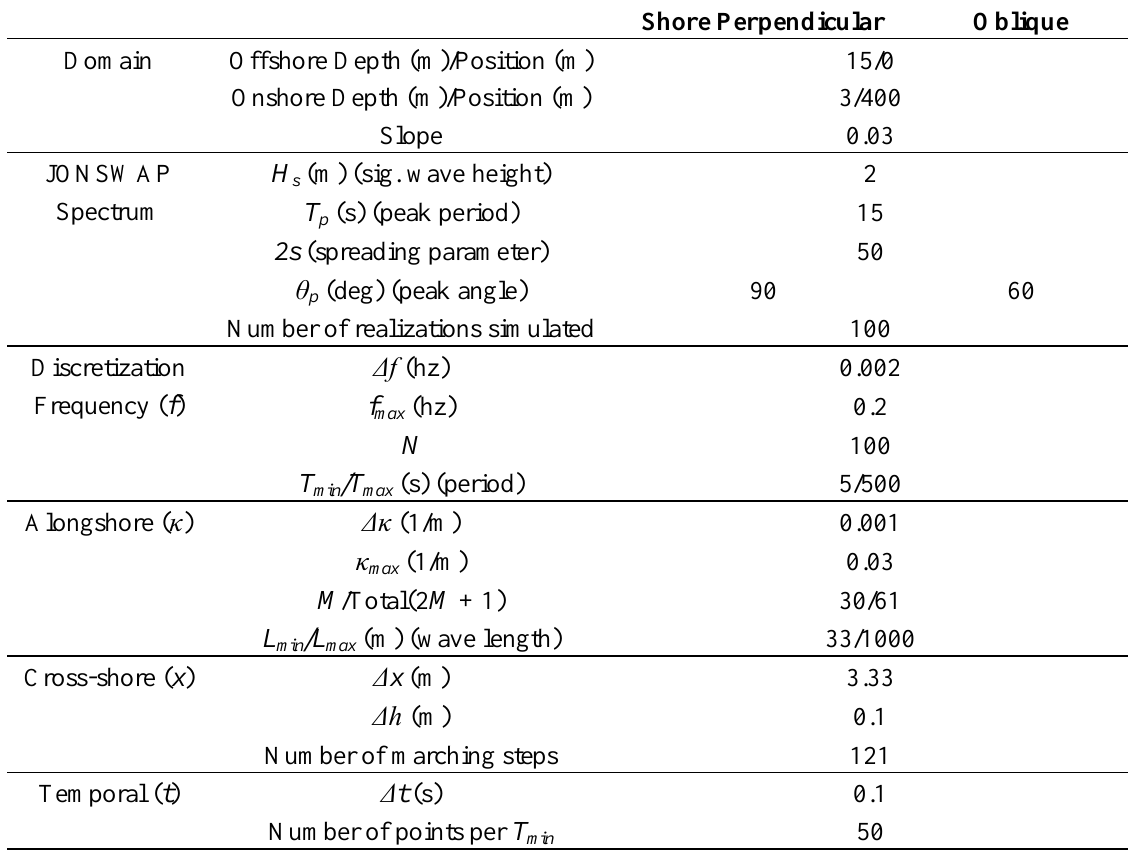
Table 1. Synthetic scenario